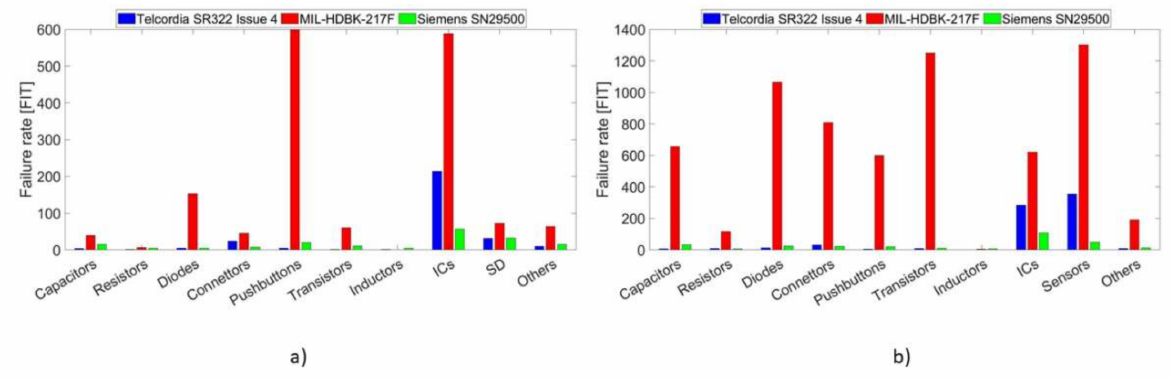
Figure 5. Comparison between failure rates of the three handbooks classified in different classes of similar components. The results of the root node are illustrated in the left side ( a ), while the right side ( b ) shows the failure rate of the components that make up the sensor